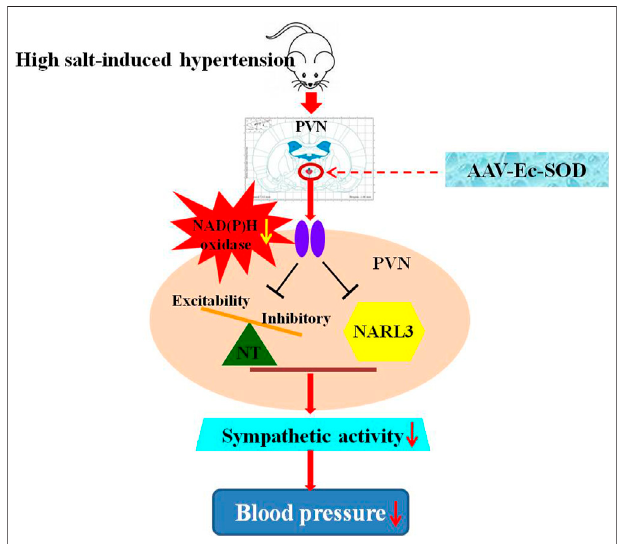
FIGURE 8 | Schematic presentation of the proposed mechanisms of Ec- SOD in salt-induced hypertension. High salt diet increased the blood pressure and sympathetic activity, which contributed to hypertension. Bilateral PVN microinjection of the overexpression of AAV-Ec-SOD inhibits the oxidative stressinthePVNanddecreasesthebloodpressure,probablythroughreducing the NLRP3-dependent in fl ammatory responses and restoring the imbalance of the neurotransmitters in the PVN during salt-induced